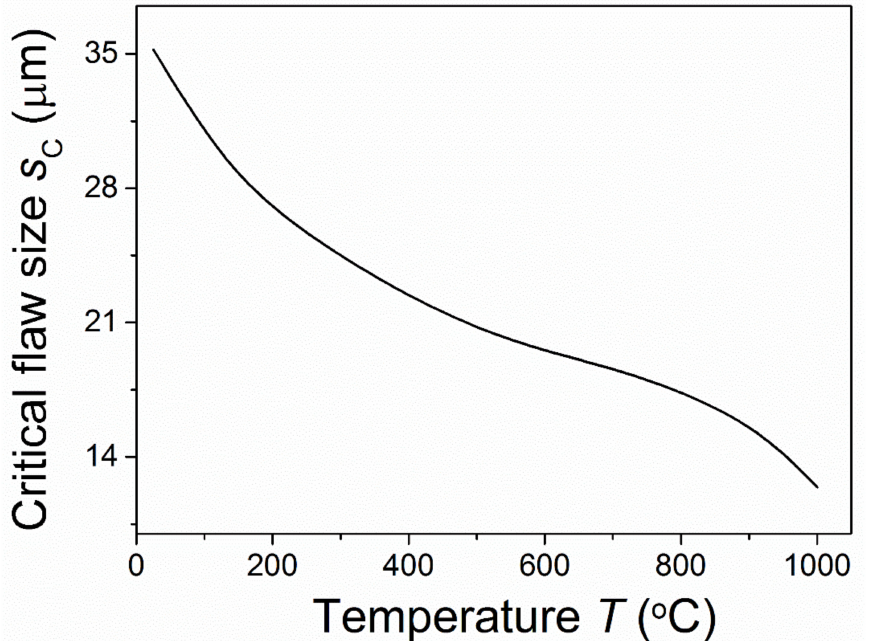
Figure 4. Temperature-dependent critical flaw size for stable crack growth.